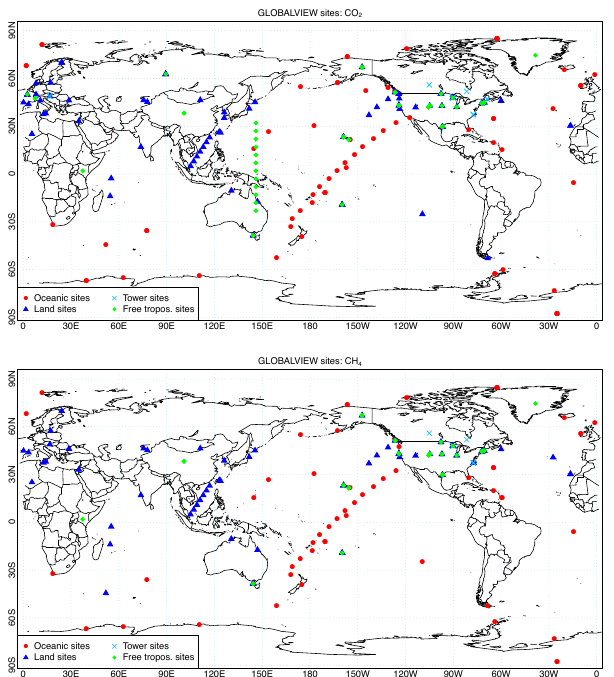
Fig. 2. GLOBALVIEW site locations used for the comparisons of CO 2 (top) and of CH 4 (bottom) for the year 2008. “Oceanic”; sites with marine-boundary-layer (MBL) marks in the GV dataset (gv table.co2 and gv table.ch4); “land”, sites below 3000m which are neither MBL sites nor tower sites; “tower”, tower sites with sam- pling platform code “3” in GV file names; “free tropos.”, free tro- posphere sites located above 3000m and marked as non-MBL sites, mostly airborne observational